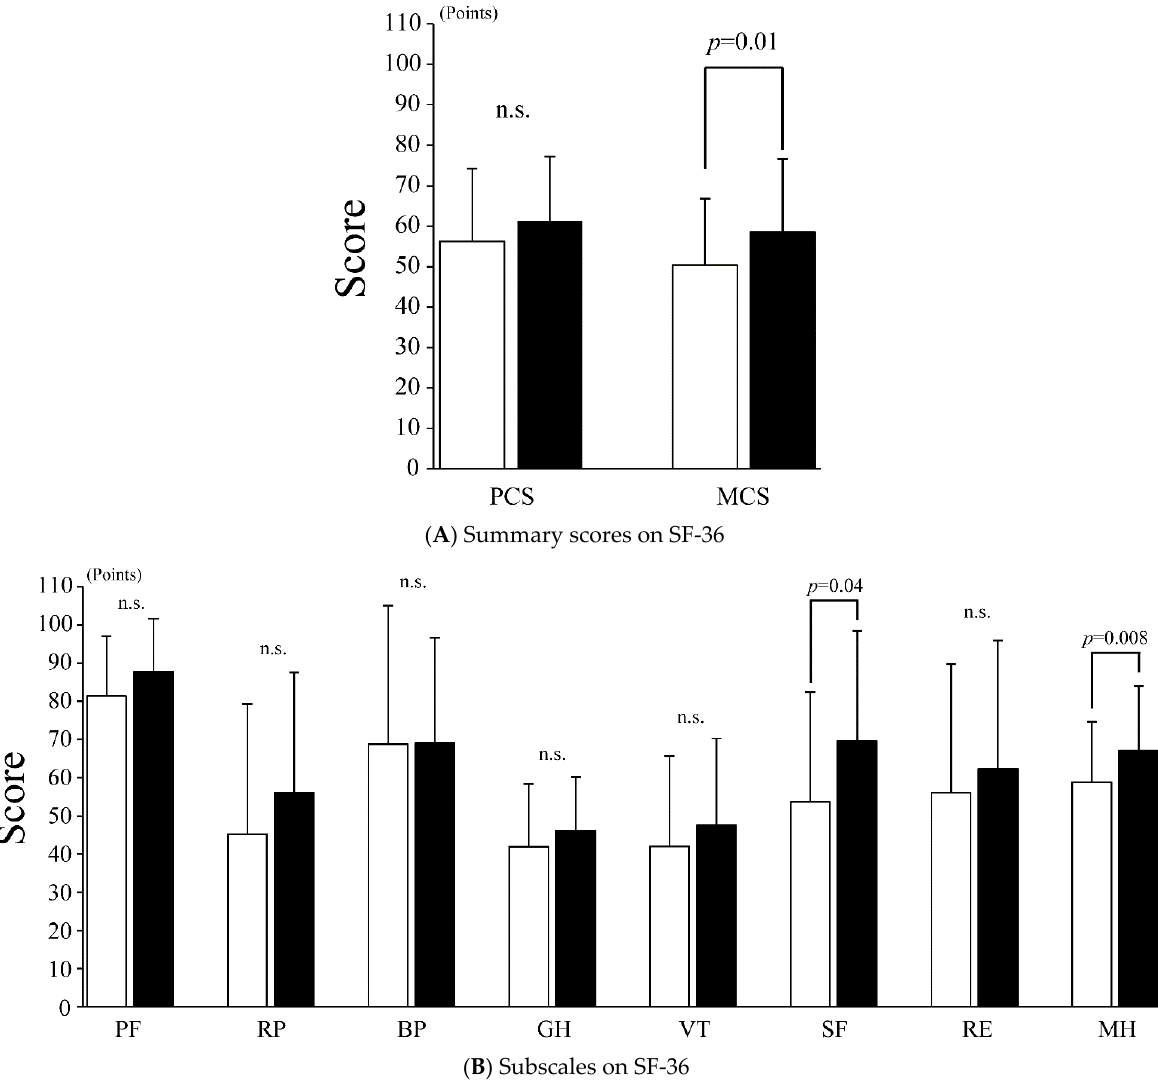
Figure 3. Quality of life by SF-36. ( A ) SF-36: 36-item short-form health survey; PCS: physical component summary; MCS: mental component summary. The white and black bars indicate the values before and after treatment, respectively. Values are presented as the mean ± SD. Error bar represents SD. ( B ) SF-36: 36-item short-form health survey; PF: physical functioning; RP: role-physical; BP: bodily pain; GH: general health; VT: vitality; SF: social functioning; RE: role-emotional; MH: mental health. White and black bars indicate values before and after treatment, respectively. Values are presented as the mean ± SD. Error bar represents SD. n.s., not significant